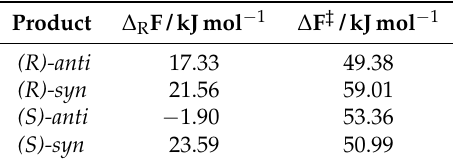
Figure 7. One-dimensional free energy profiles of aldol reactions (R=Et) in vacuum obtained from HyAIMD metadynamics; corresponds to red curves in Figure 6. Free energies are given relative to educts. Table 3. Total reaction free energies ∆ R F and reaction free energy barriers ∆ F ‡ for the aldol reactions (R=Et) in vacuum from HyAIMD metadynamics; extracted from Figure 7. Free energies are given relative to